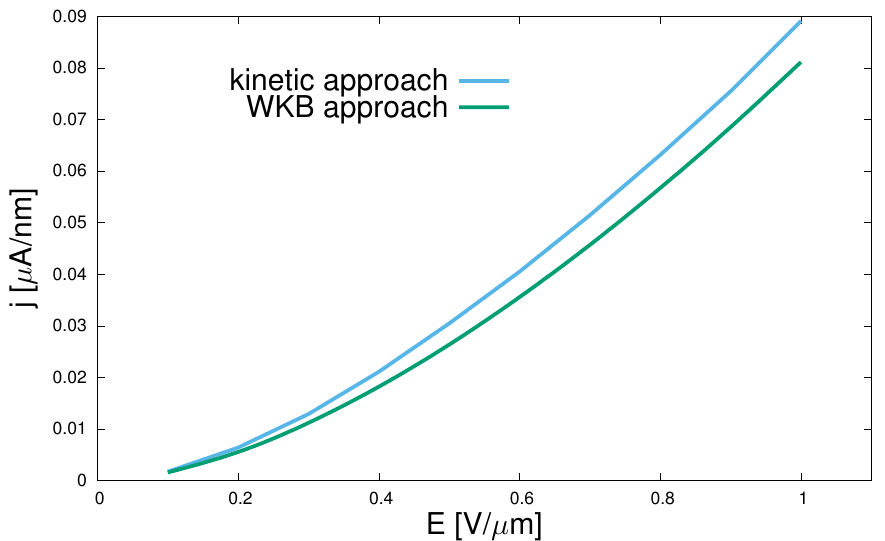
Figure 3. Comparison of calculated conduction current density for a sample with L = 100 nm in the range of electrical field strengths E from 0.1 V/ µ m to 1.0 V/ µ m (potential differences from 0.01 V to 0.1